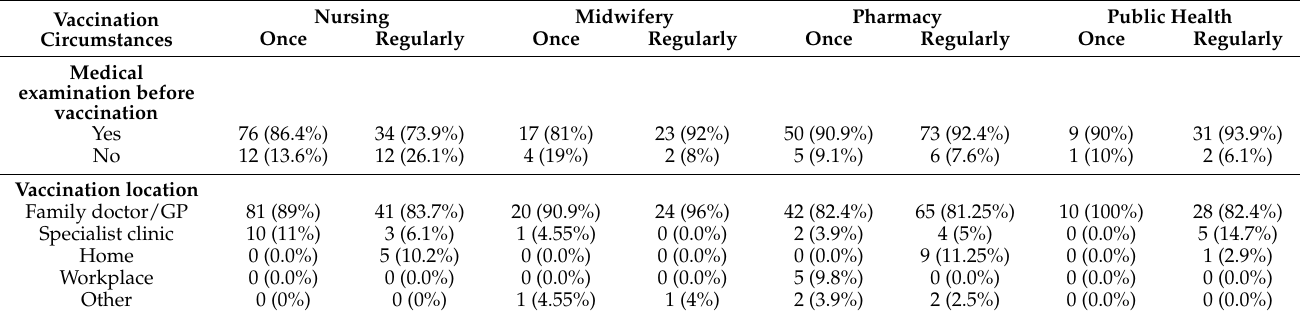
Table 4. Qualification for vaccination and its location, according to student major and frequency of vaccination. Vaccination